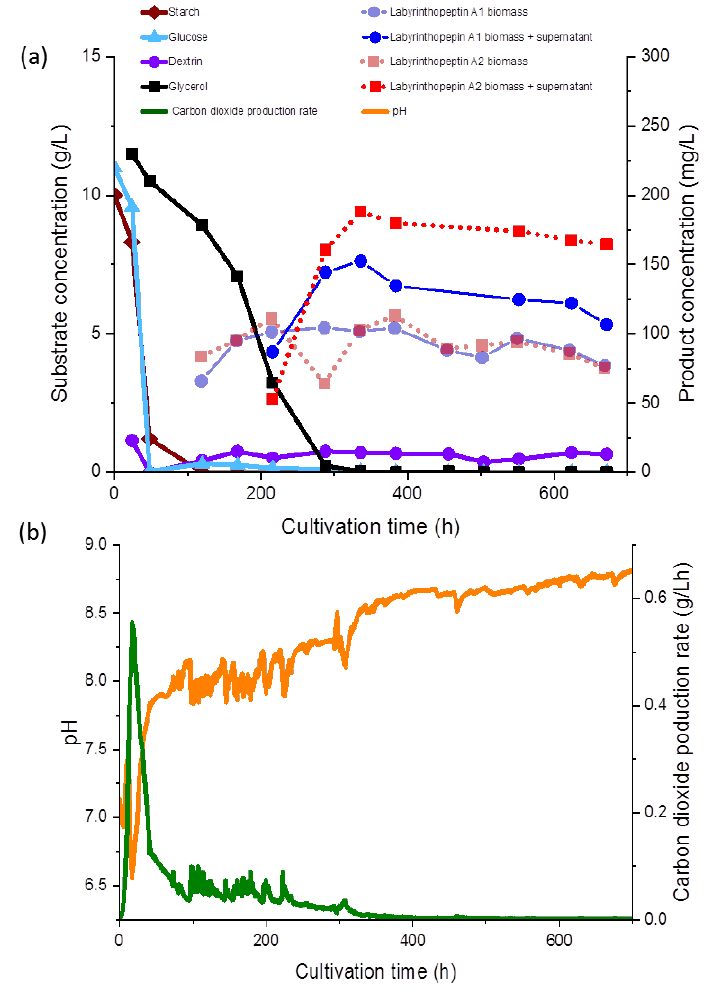
Figure 3. ( a ) Correlation between product concentration (mg/L) and substrate concentrations (g/L); ( b ) carbon dioxide production (CPR; g/Lh) and pH determined during regular time intervals in a 10 L batch fermentation. Product concentration is expressed as a cumulative value for the biomass and the supernatant together (dashed lines) and for the biomass only (solid lines).